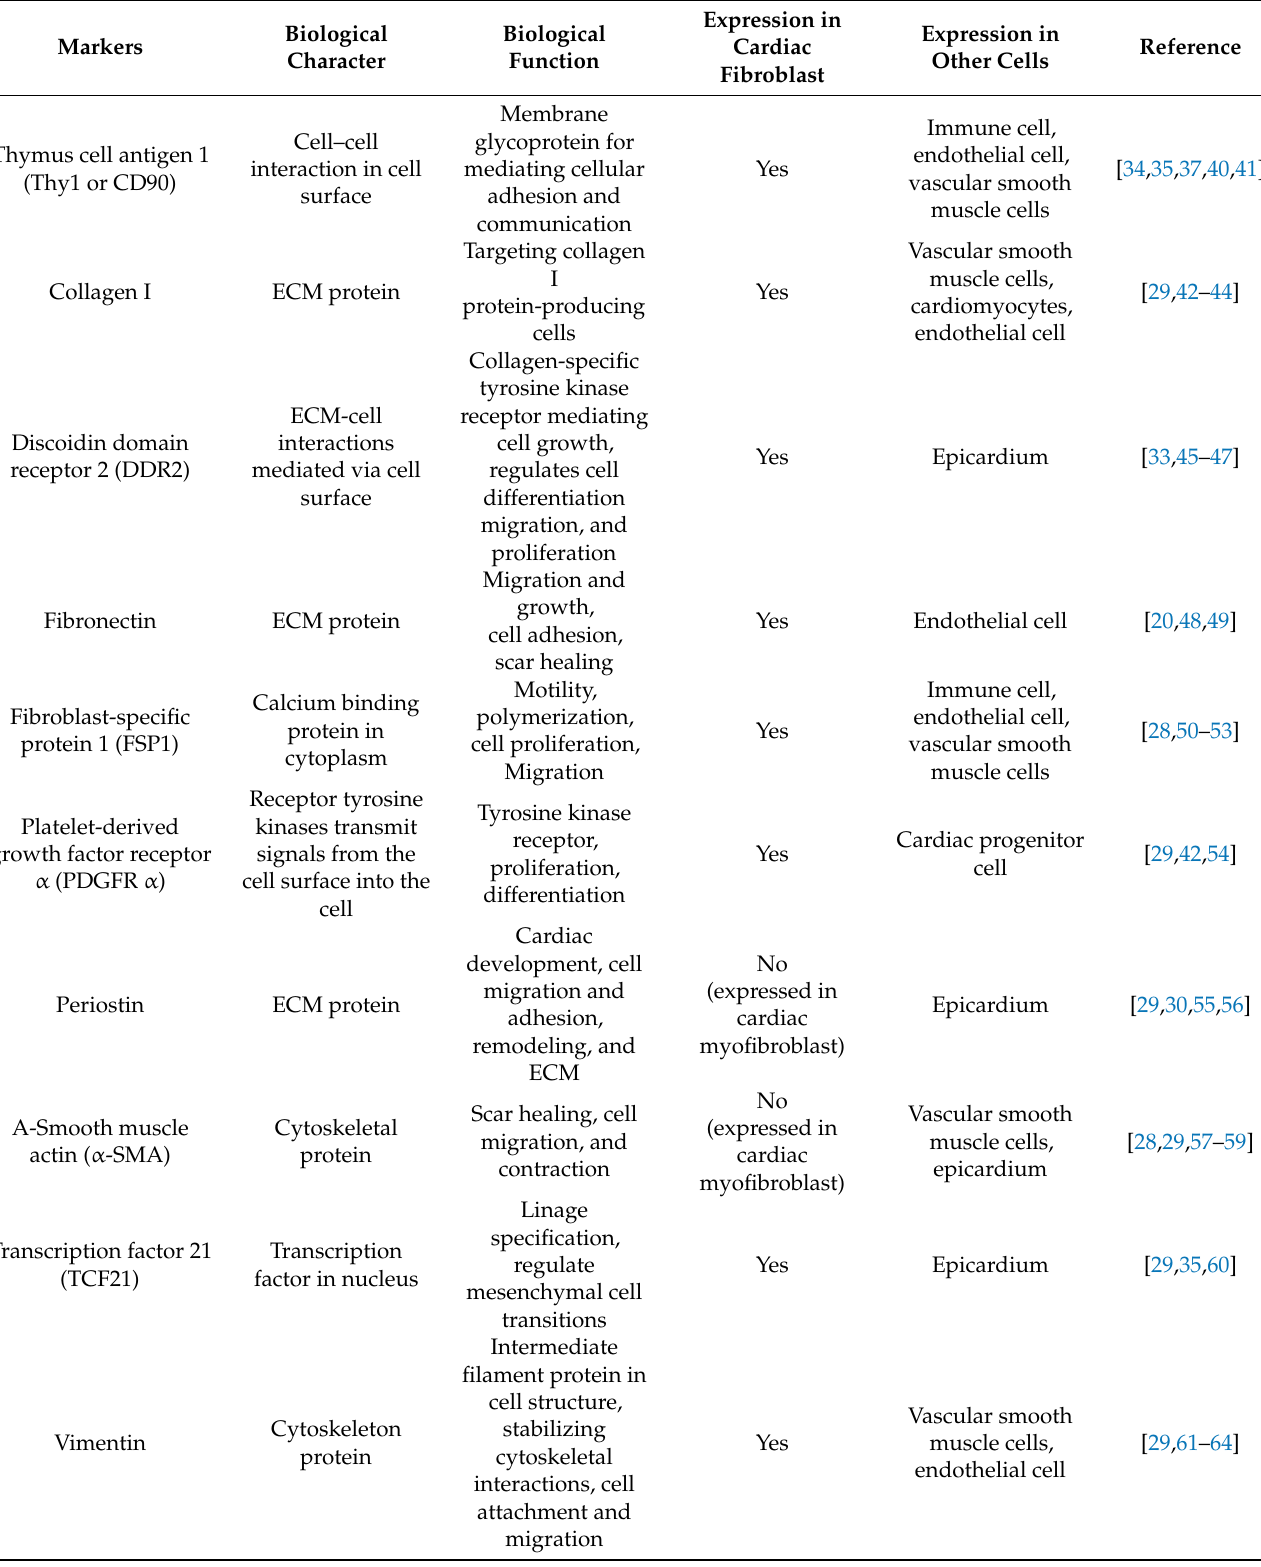
Table 1. List of molecular markers used for the identification of cardiac